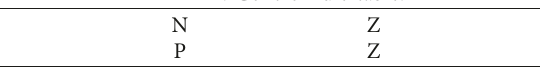
Table 1: Control rule table.